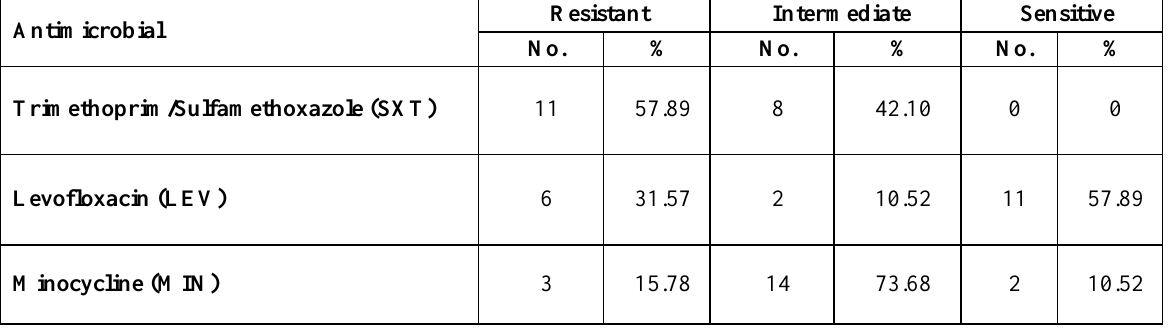
Table 2. Susceptibility pattern of the 19 non-susceptible S. maltophilia isolates. Antimicrobial